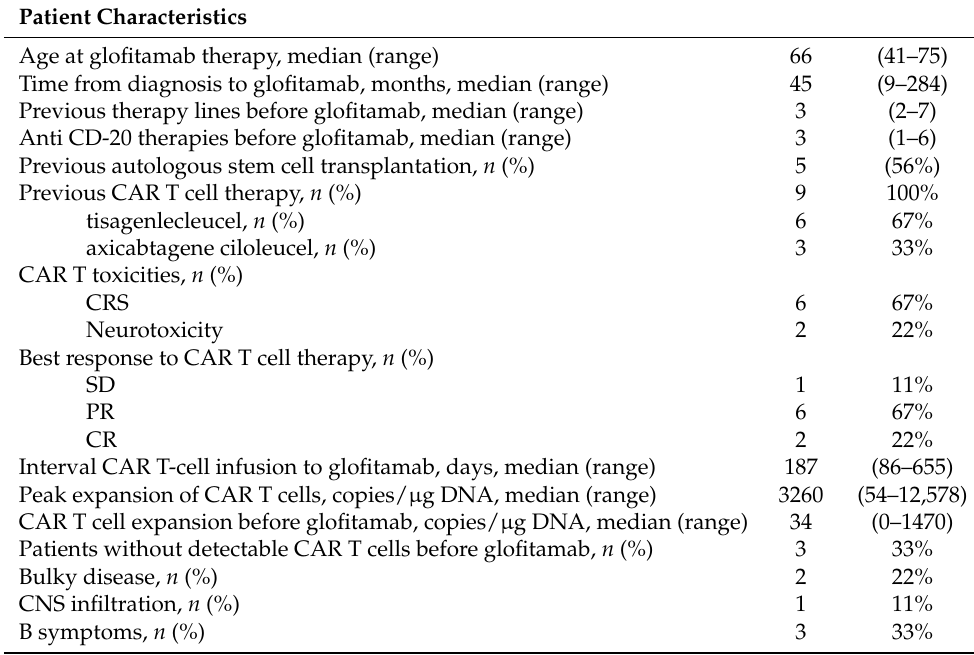
Table 2. Patient characteristics at start of Glofitamab therapy. Patient